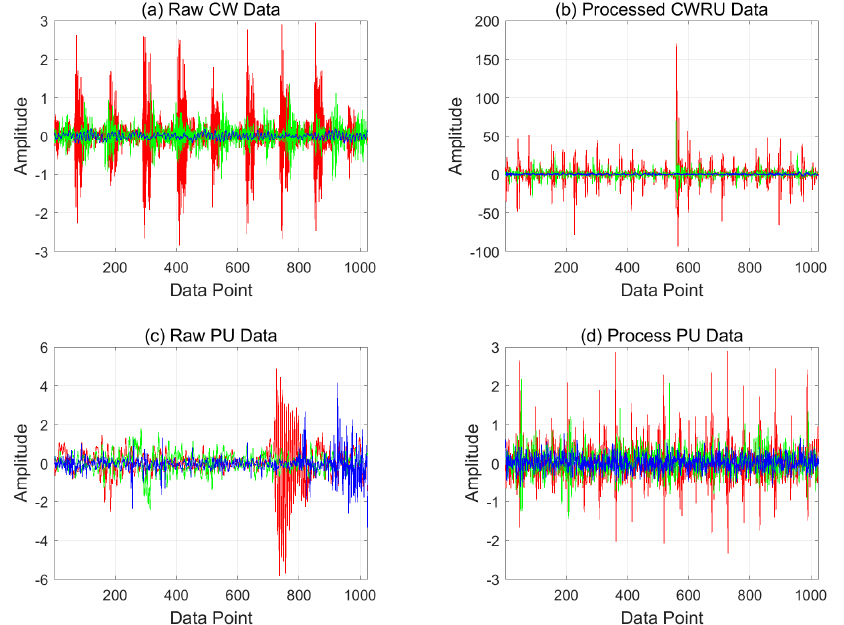
Figure 9. Raw data and processed data: blue lines—normal, green lines—inner raceway fault, red lines—outer raceway fault.